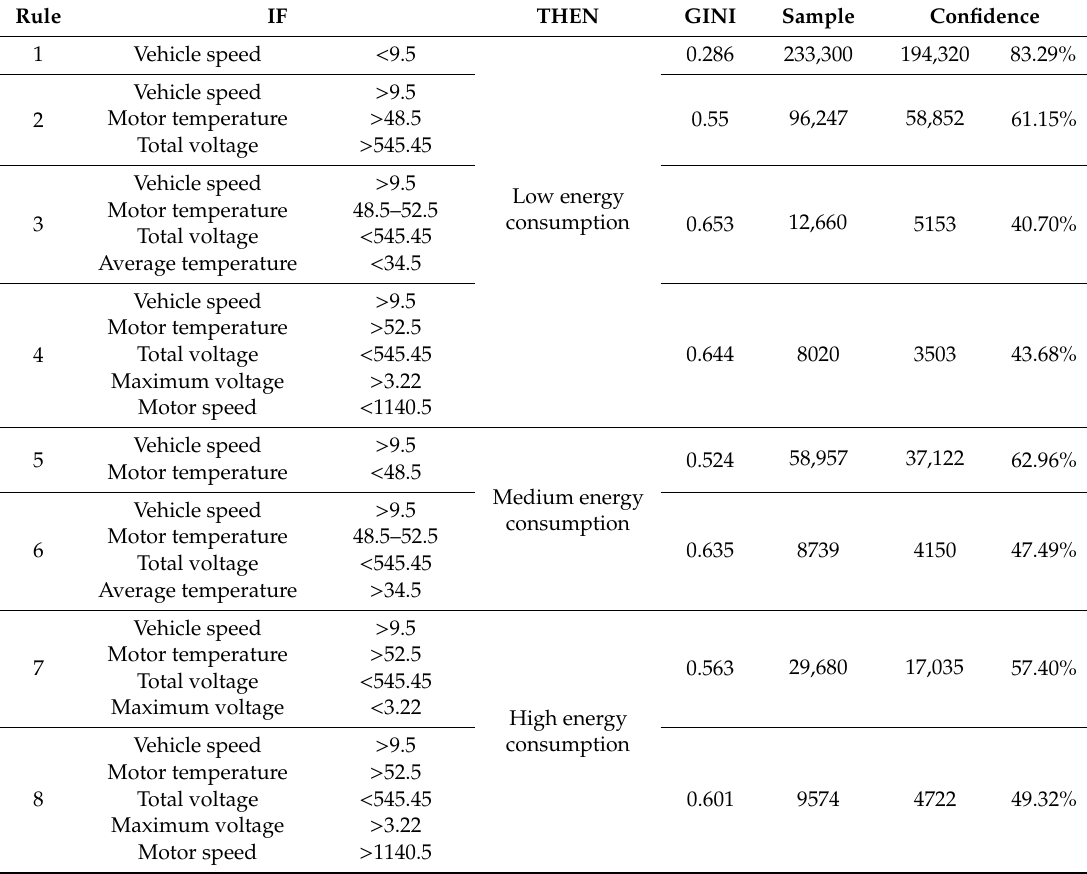
Table 13. Classification rules of route 352 in the case